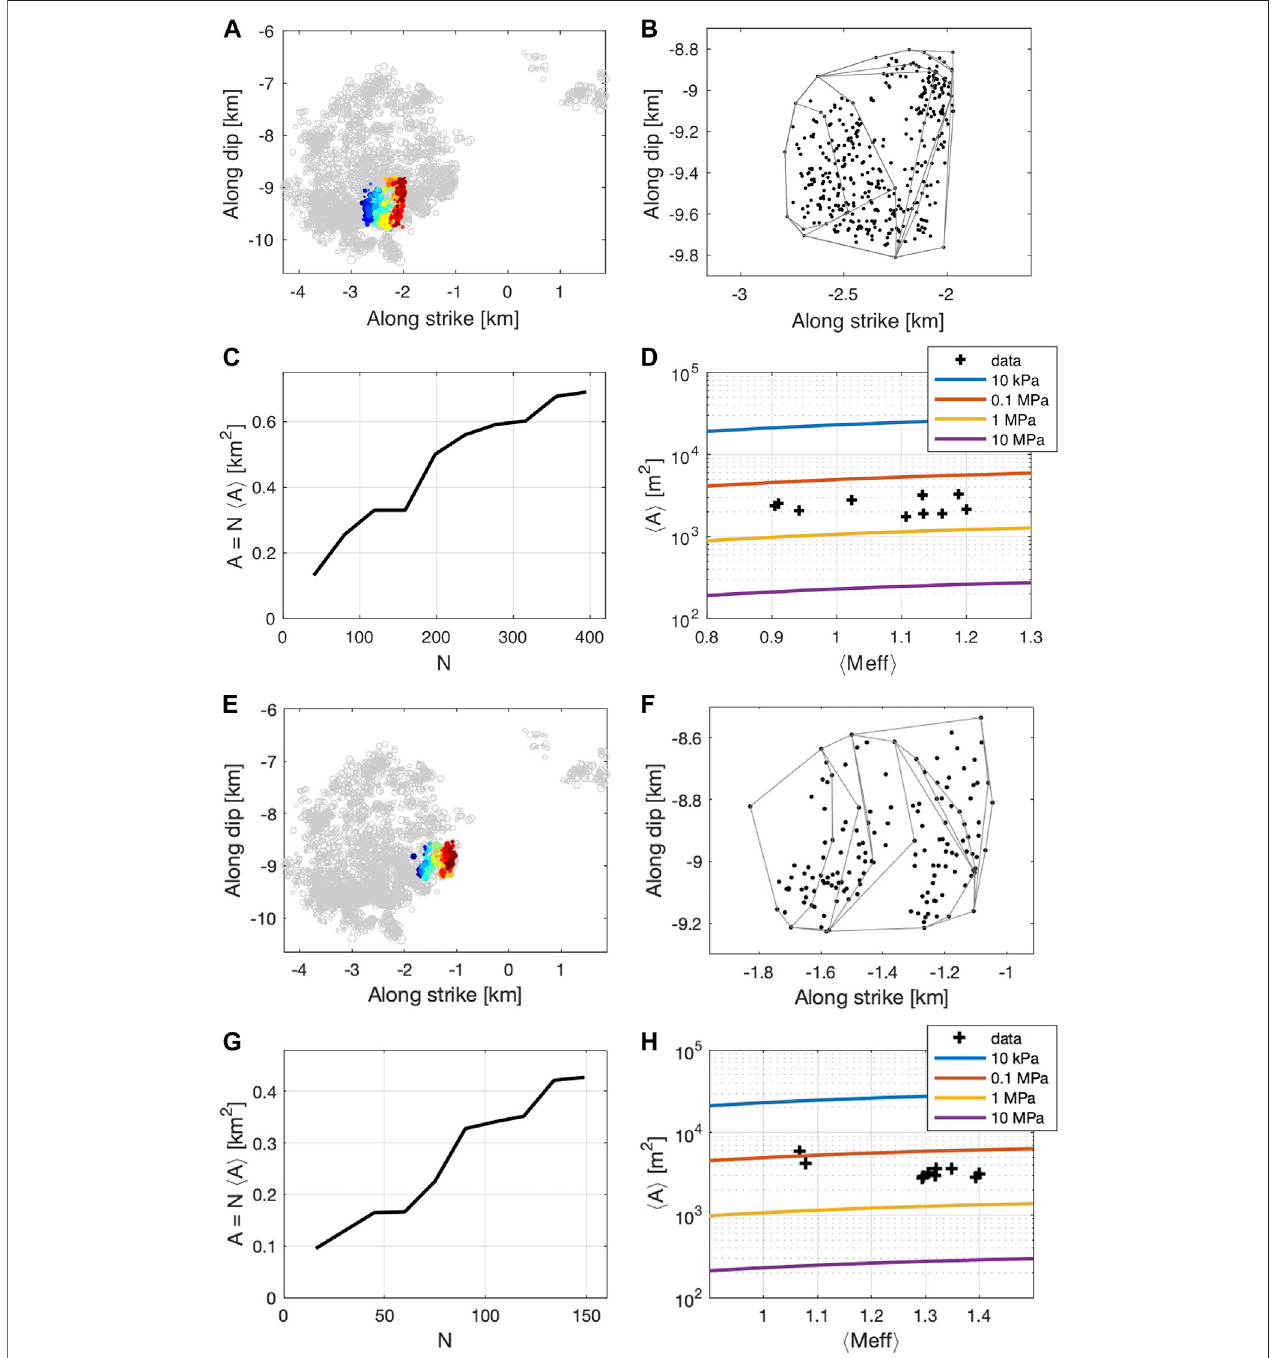
FIGURE 5 | Growth analysis of the two clusters of the 2008 West-Bohemia swarm identi fi ed in Figure 4 : The activated area is marked in colors, which are proportionaltotheeventindex (A,E) ;its convexhull wasdetermined (B,F) for extending equidistant windows thatincluded from 10to100%ofevents;thescaling ofthe total rupture area with the number of events is almost linear (C,D) . The dependence of the average rupture area per event 〈 A 〉 on the average observed effective magnitude 〈 M eff 〉 is examined (D,H)